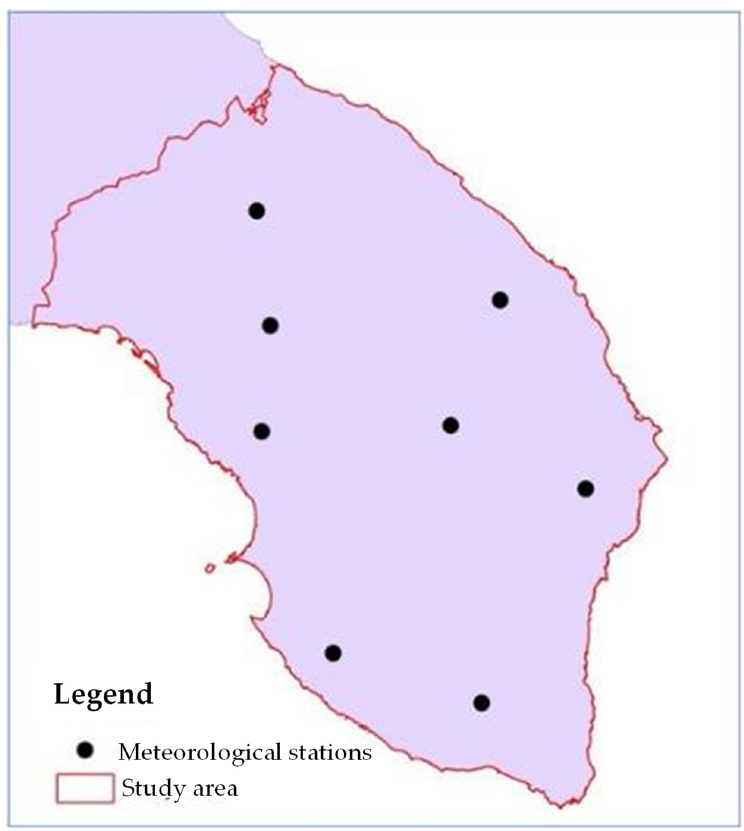
Figure 3. Meteorological stations used to calculate the average air temperature and cumulated precipitation in the study area from 2014 to 2020 in the six days before the Landsat images acquisitions.